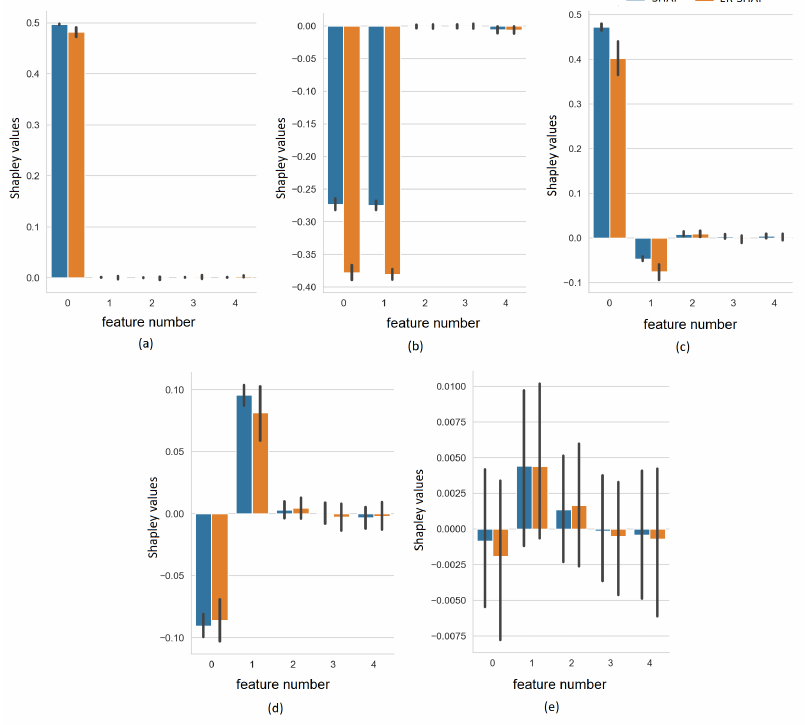
Figure 10. Shapley values obtained by means of SHAP and ERW-SHAP for all features of five datasets depicted in corresponding Figure 4a–e and trained SVMs under condition of using the normal distribution of feature changes with the standard deviation